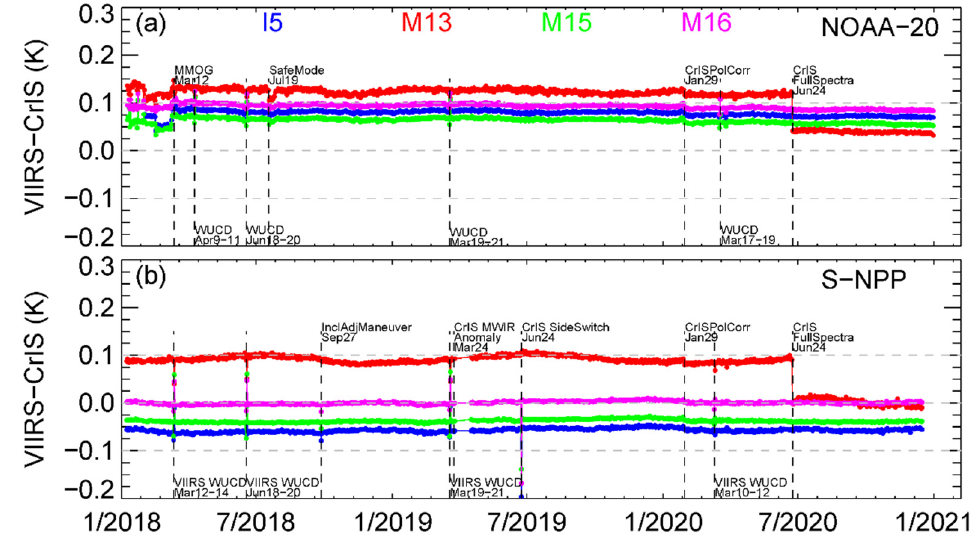
Figure 9. NOAA-20 ( a ) and S-NPP ( b ) daily averaged VIIRS–CrIS BT difference time series. Major on-orbit events were labeled.